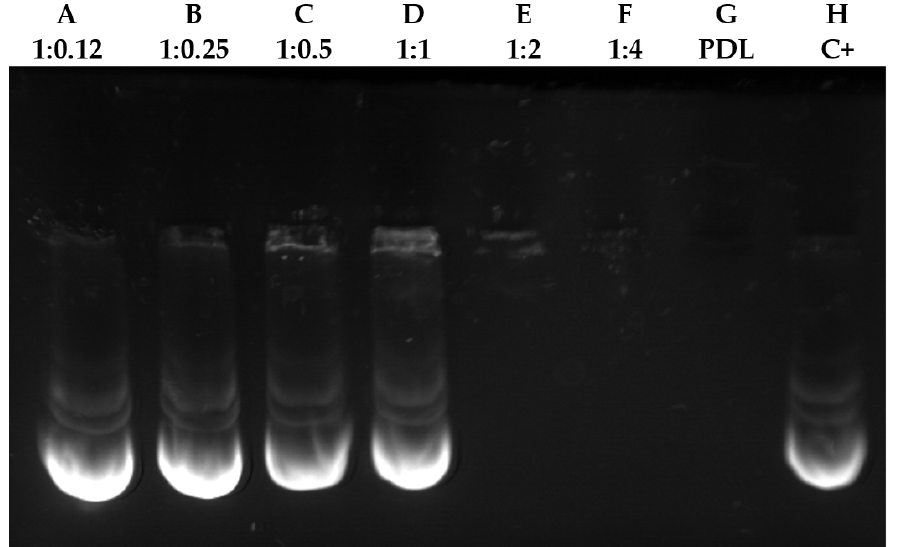
Figure 1. Interaction analysis between different plasmid/PDL ratios. Interaction analysis of plasmid–PDL complex at different ratios in agarose gel (0.8%) stained with GreenSafe. Columns A–F show the different plasmid/PDL ratios used (1:012, 1:0.25, 1:05, 1:1, 1:2, 1:4 and 1:8 respectively). Column G only contains PDL and column H was used as a positive control where only DNA was inserted.